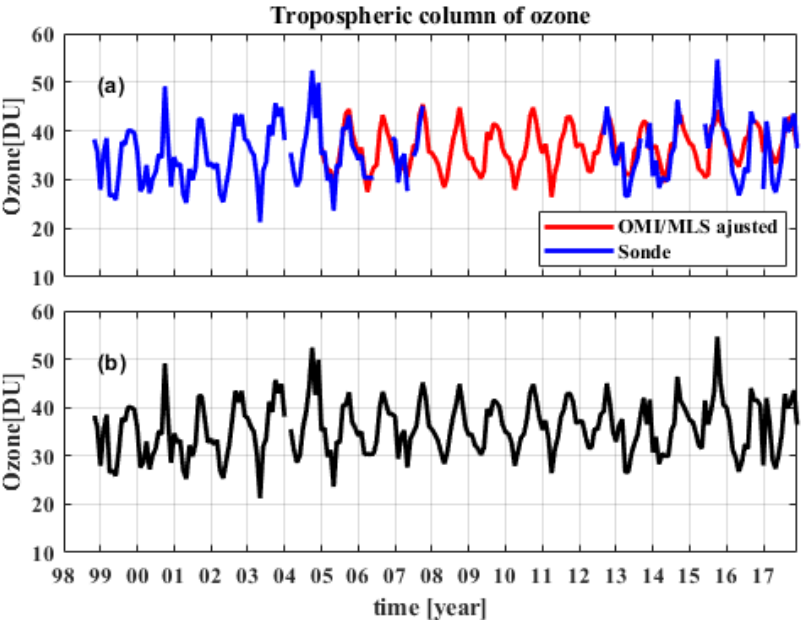
Figure 6. ( a ) The time-evolution of total ozone adjusted using satellite data on ozonesonde observation (in blue line) and ( b ) time-evolution of TPC as obtained from a combination between radiosonde and adjusted satellite data.